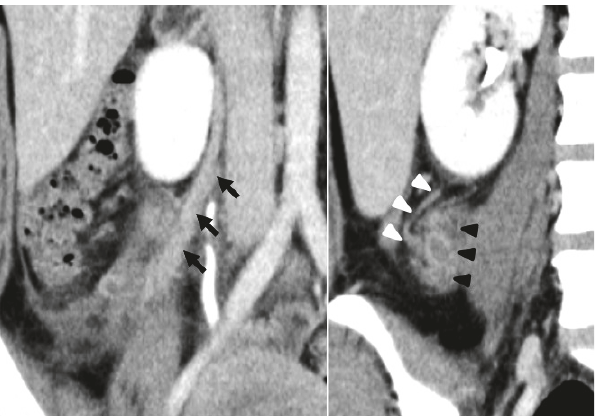
Figure 2: Abdominal dynamic CT scan reconstructed after surgery (delayed phase). Intact right ovarian vein (black arrow) (left). The retroperitoneal mass (black arrowhead) was connected to the right renal capsular vein (white arrowhead) (right).